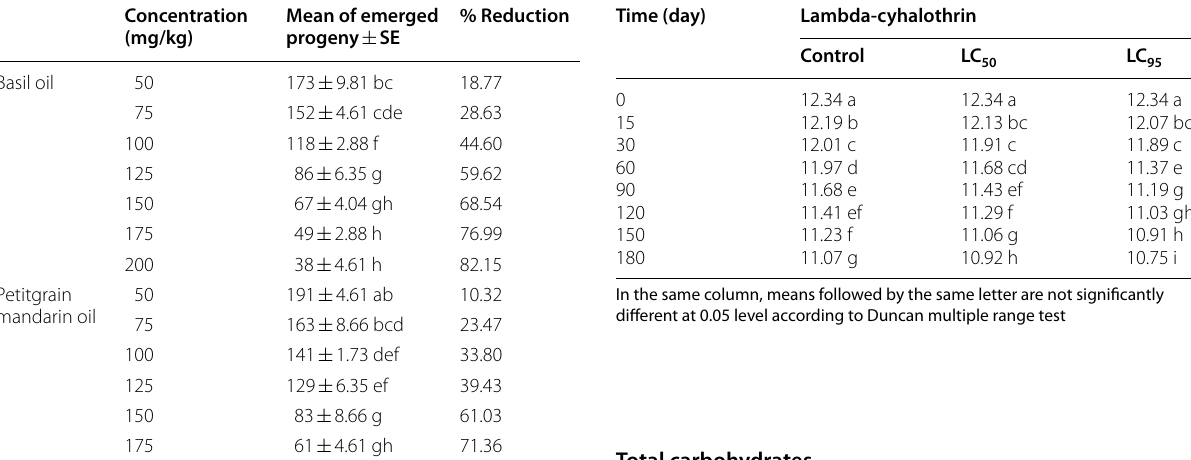
Table 7 Effect of lambda‑cyhalothrin on crude protein